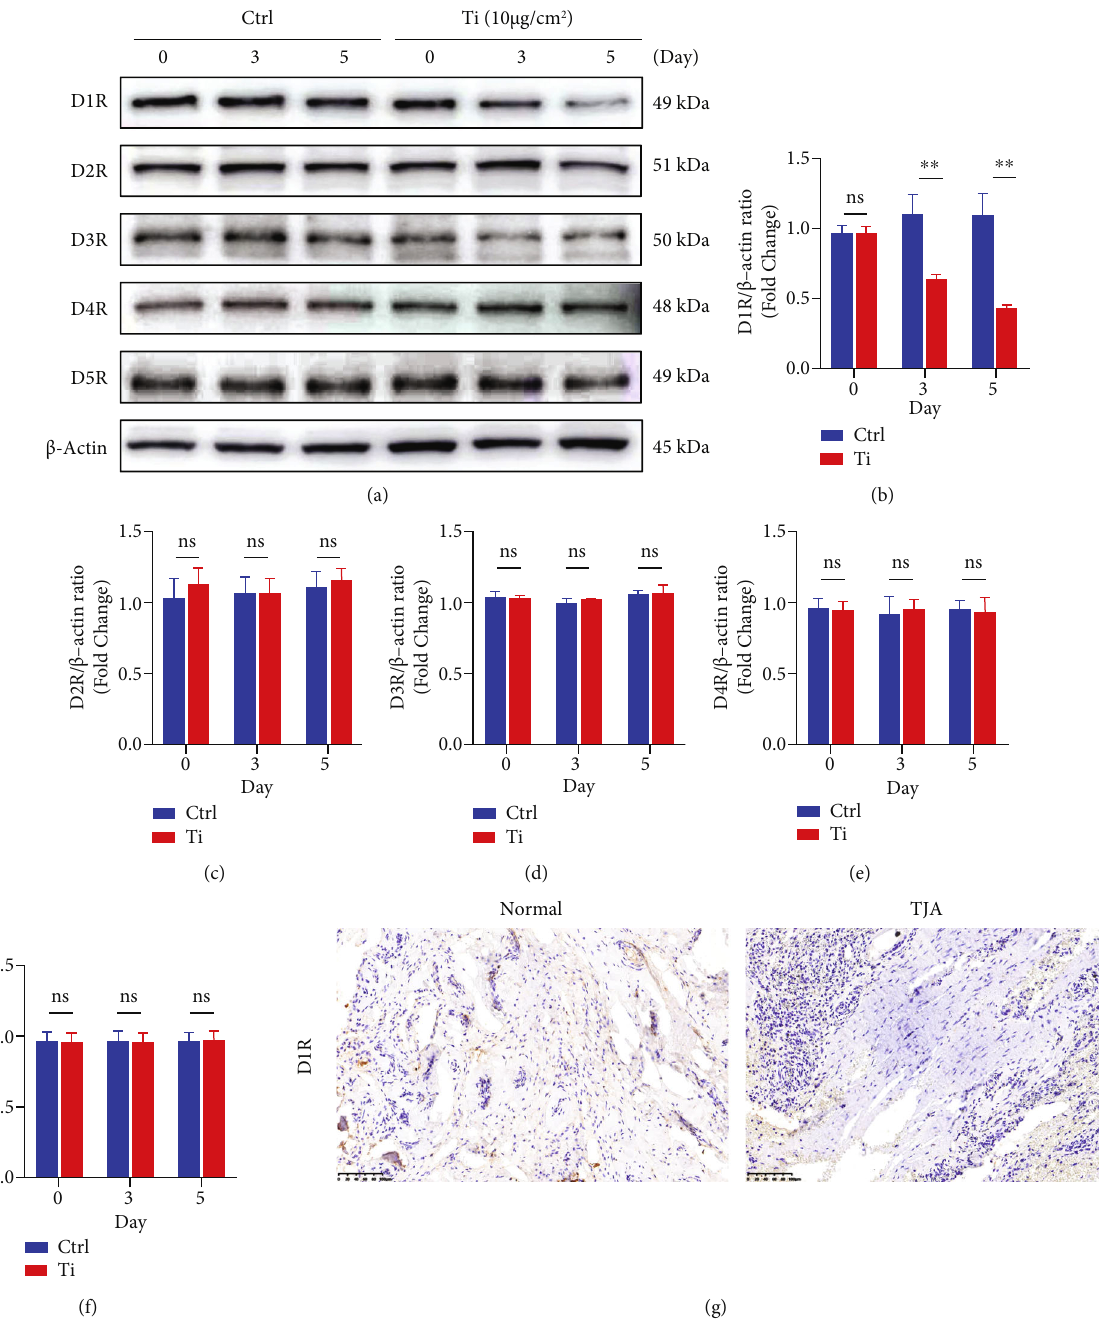
Figure 2: Titanium particles inhibit D1R expression in vitro and ex vivo of human. (a) Representative images of western blots probed with antibodies against D1R, D2R, D3R, D4R, and D5R. (b – f) Quanti fi cation of D1R, D2R, D3R, D4R, and D5R protein levels. n = 3 per group. NS: not statistically signi fi cant, ∗ P < 0 : 05 and ∗∗ P < 0 : 01 vs. the ctrl group at the same time point. (g) Representative images showing IHC staining of D1R in human synovial specimens. Scale bar: 50 μ